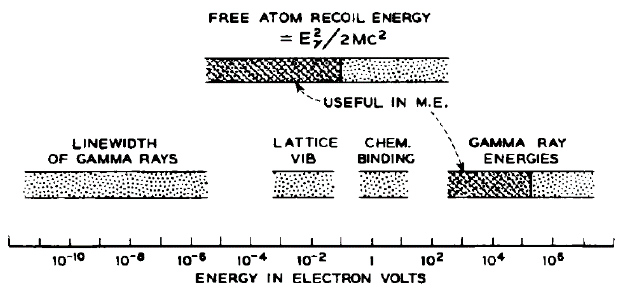
Figure 6. Energy scale of nuclear and atomic events relative to the Mössbauer effect. Reproduced from [26].